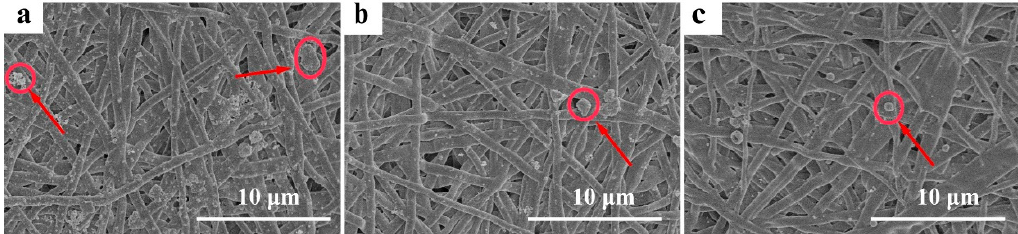
Figure 6. SEM images of platelet adhesion on fibrous meshes: ( a ) PCL-PIBMD meshes; ( b ) PCL-PIBMD/MPs meshes; and ( c ) PCL-PIBMD/MPs-pZNF580 meshes. In the case of PCL-PIBMD, the adhered platelets showed more aggregation, as indicated by red arrows and circles.